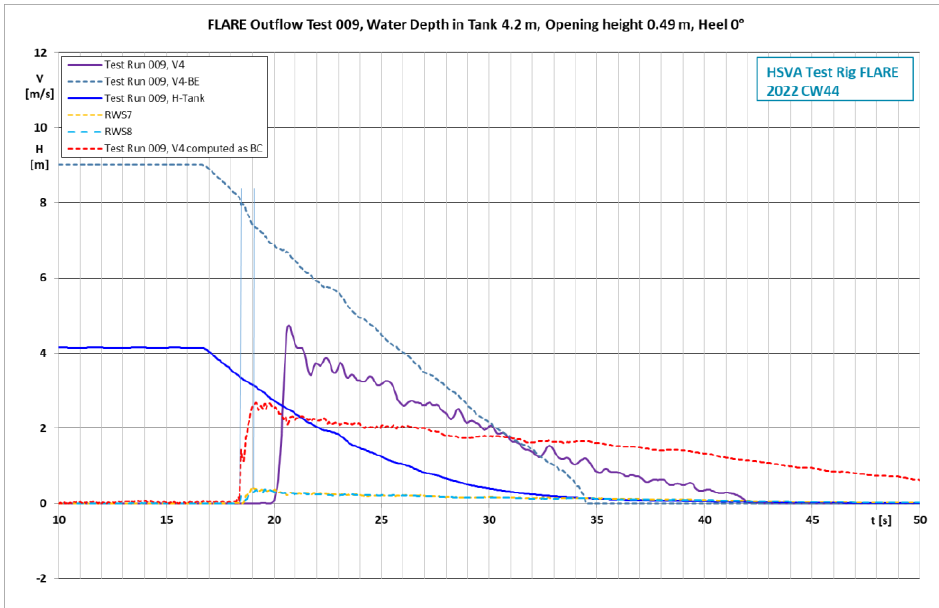
Figure A4. Flow speed V 4 and water elevations RWS7 and RSW8 at the fourth section S 4 for the test run 009. In addition, the red dashed curve shows the flow speed V 4 computed with BE as the typical boundary condition at the damage opening.